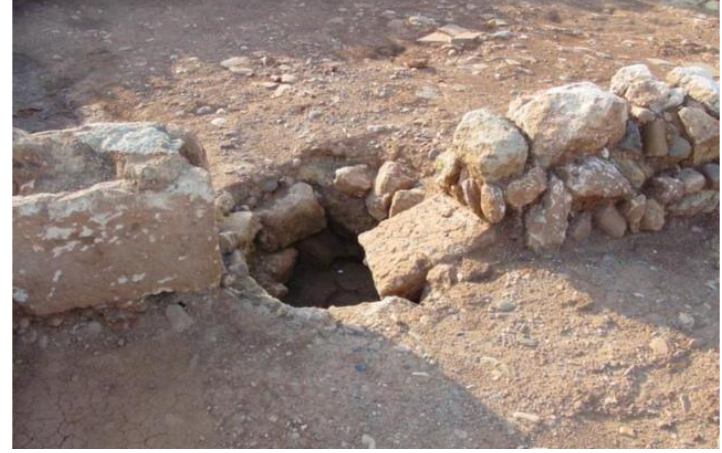
Figure 29. Water well shared by Houses 24a and 24b, which suggests that they were originally part of a single house (Aparicio Sánchez 2017, Figure